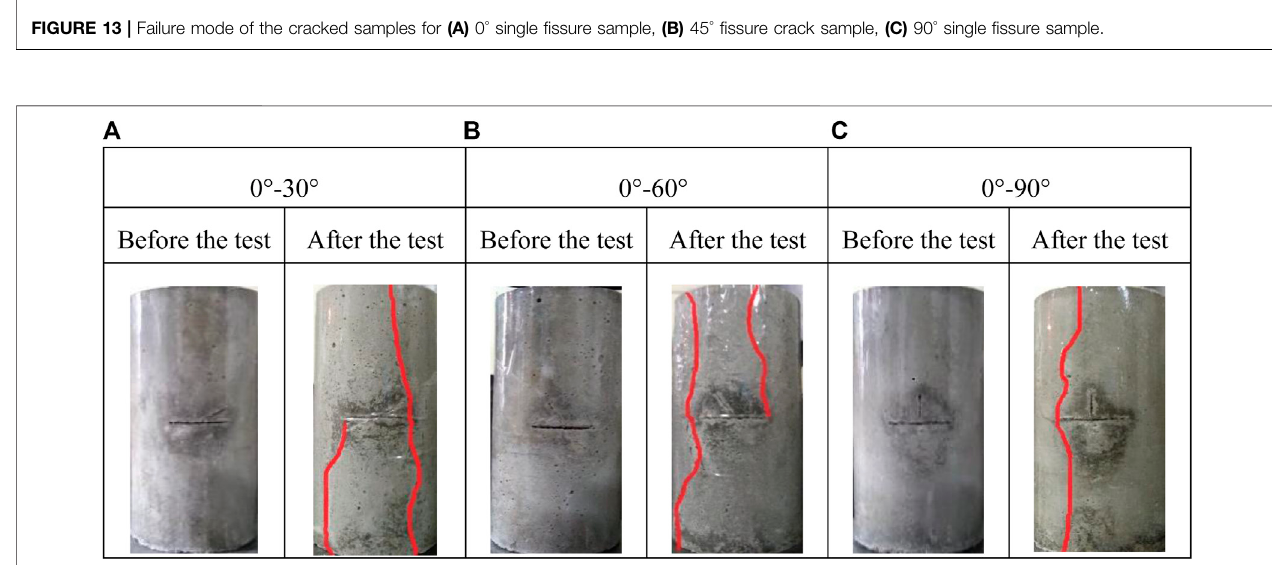
FIGURE 14 | Failure mode of the cracked samples for (A) T-shaped cracked sample of 0 ° – 30 ° , (B) T-shaped cracked sample of 0 ° – 60 ° , (C) T-shaped cracked sample of 0 ° – 90 ° .